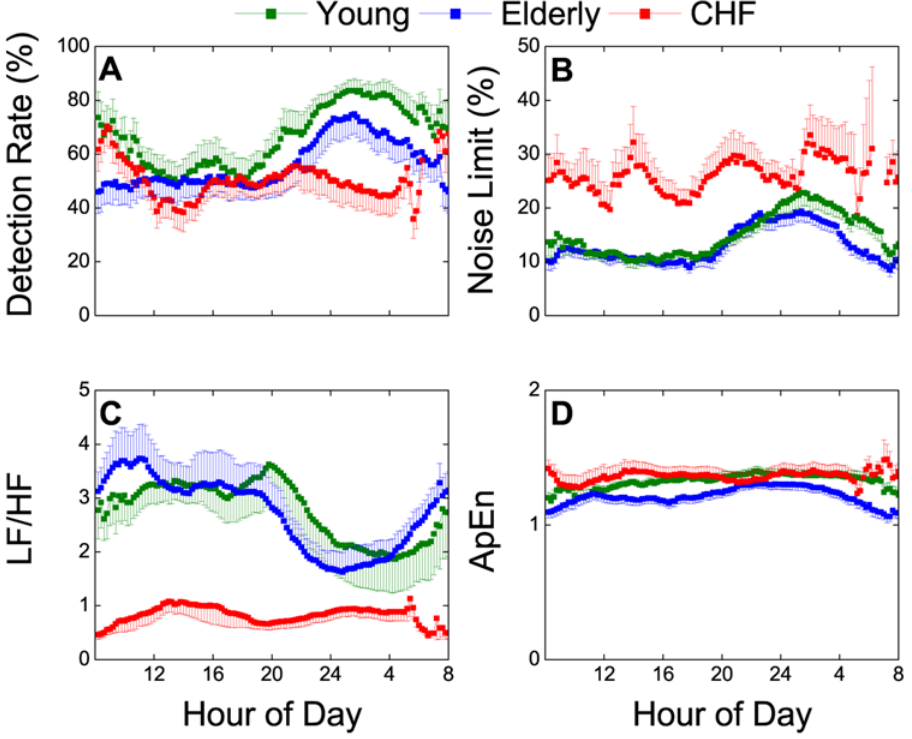
Figure 3. Chaotic vs. spectral and stochastic measures of heart rate variability in young, elderly and CHF groups. A. Detection rate (DR). B. Noise limit (NL). C. LF/HF power ratio. D. Approximate entropy (ApEn). The average DR and NL and LF/HF values were not significantly different between the young and elderly groups (repeated measures ANOVA, P . 0.1) but were markedly different in the CHF group. The elderly group had significantly different ApEn values than the young group (P=0.02) and CHF group (P=0.04) but the difference between the young and CHF groups were marginal (P=0.61). doi:10.1371/journal.pone.0004323.g003 PLoS ONE |